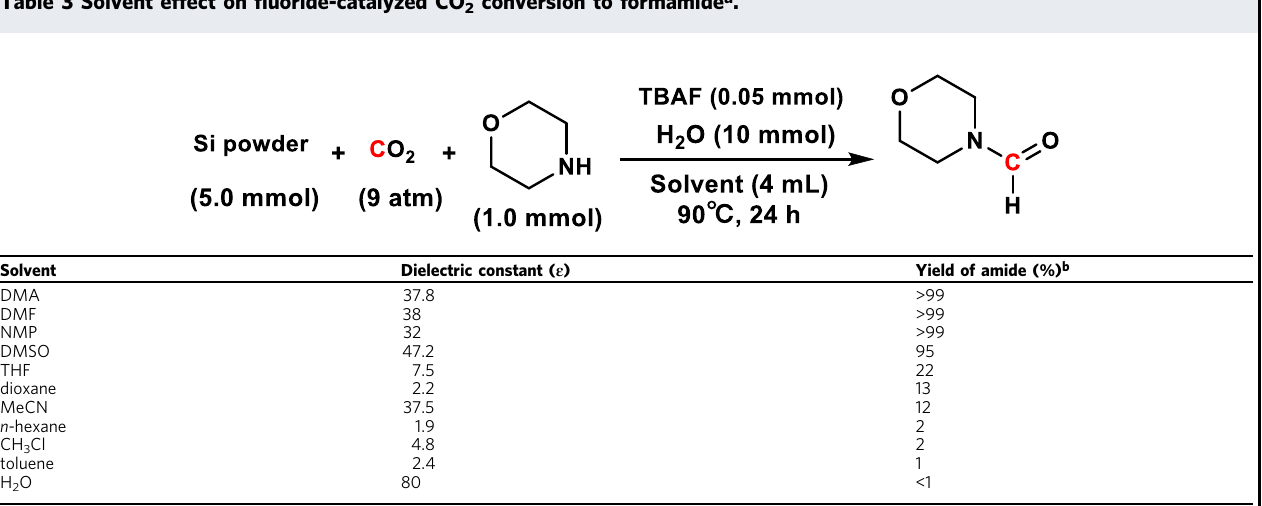
Table 3 Solvent effect on fl uoride-catalyzed CO 2 conversion to formamide a .